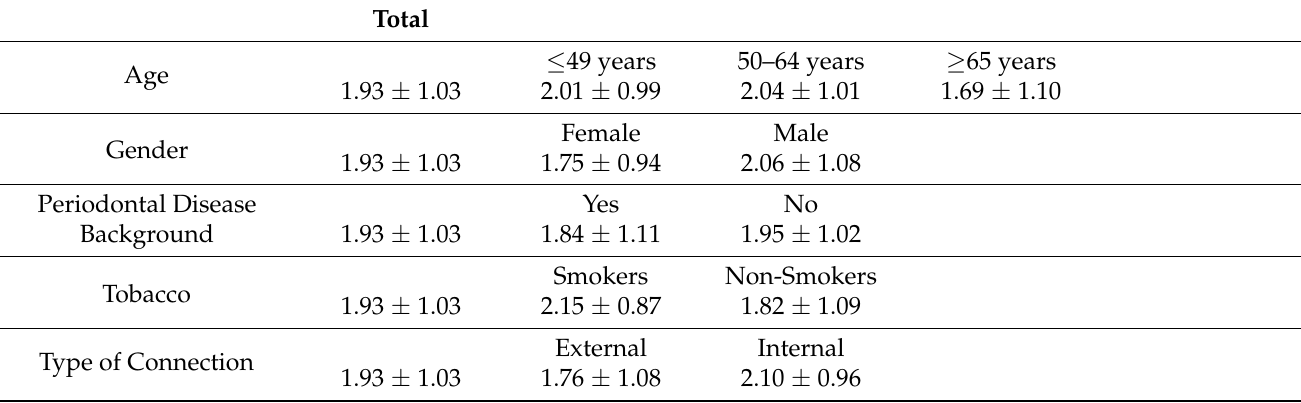
Table 2. Data regarding marginal bone loss